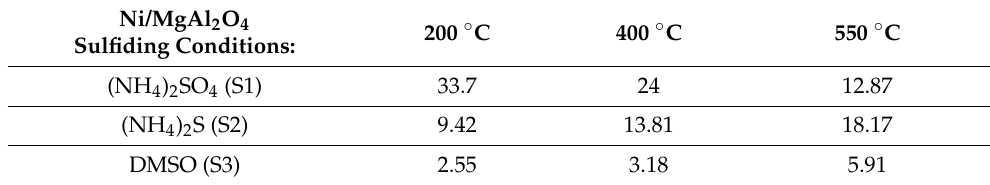
Table 1. EDS data showing wt% S on catalysts sulfided at 200 ◦ C, 400 ◦ C, and 550 ◦ C. Ni/MgAl 2 O 4 Sulfiding